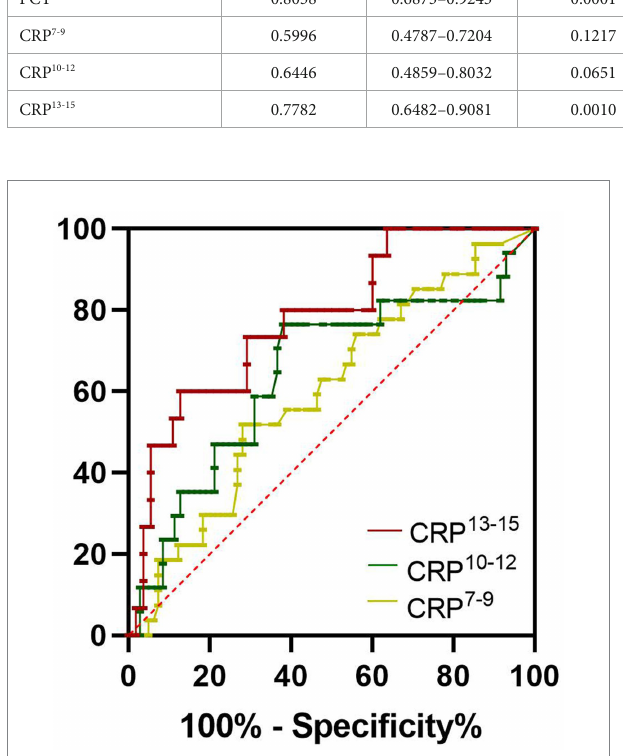
FIGURE 4 Receiver operating characteristics curves showing the performance of CRP to predict the mortality of SFTS patients at different periods. CRP 7-9 , CRP 10-12 , and CRP 10-12 indicated the CRP levels at 7–9 days, at 10–12 days, and 13–15 days from symptom onset, respectively. The AUC of CRP 7-9 = 0.5996, The AUC of CRP 10-12 = 0.6446, The AUC of CRP 13-15 =